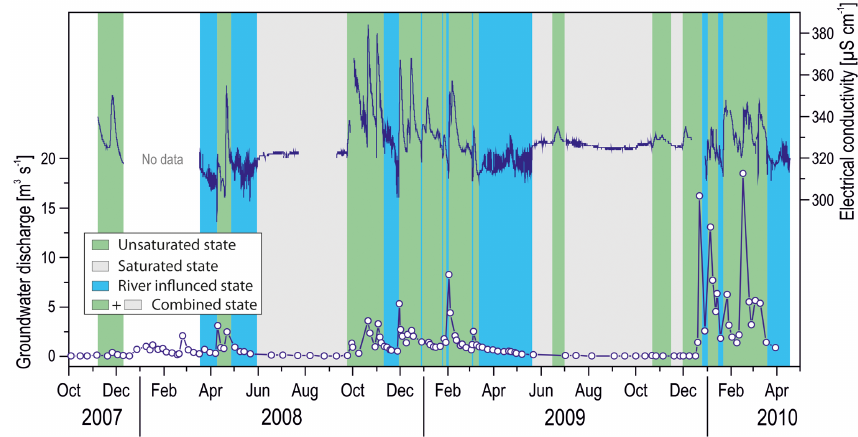
Figure 2. Decomposition of the El Burgo spring flow in selected hydrochemical states from EC and discharge time series: (1) unsaturated zone dominates discharge; (2) saturated zone dominates discharge; and (3) discharge (and EC) influenced by the Turón river flow; the combination of unsaturated and saturated states represents the combined flow